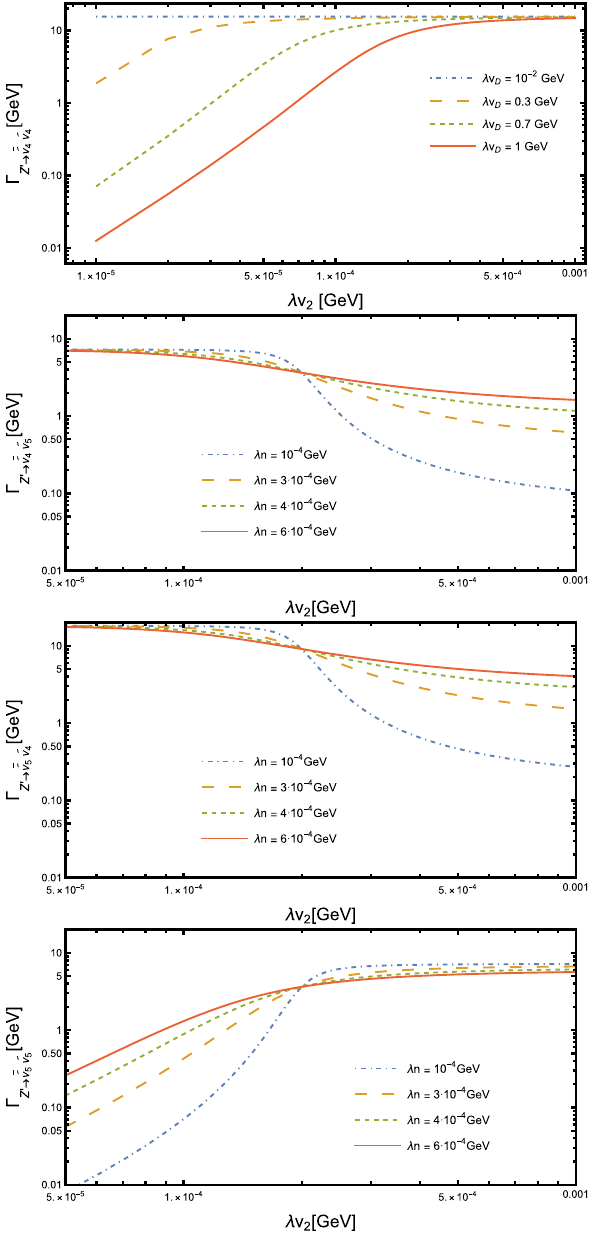
Fig. 8 Z (cid:2) decay rates into ˜ ν i ˜ ν j mixed state with i , j = 4 , 5 as a func- tion of λv 2 for different values of λ n . M Z (cid:2) = 7 TeV